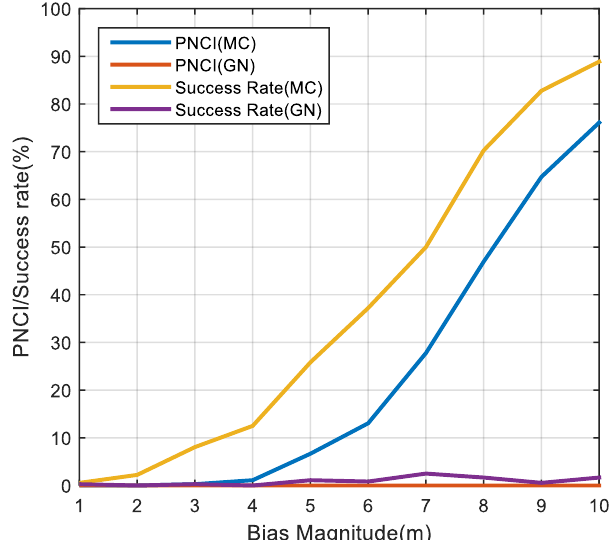
Figure 14. PNCI and success rate of the MC algorithm and ML algorithm under multiple NLOS scenario.